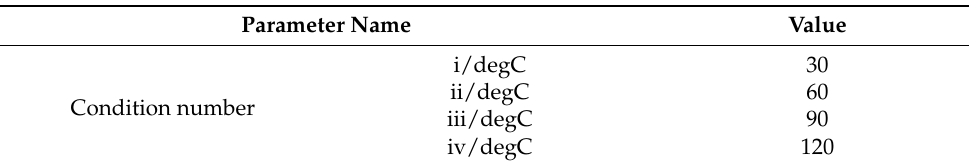
Table 6. Oil temperature under different working conditions.